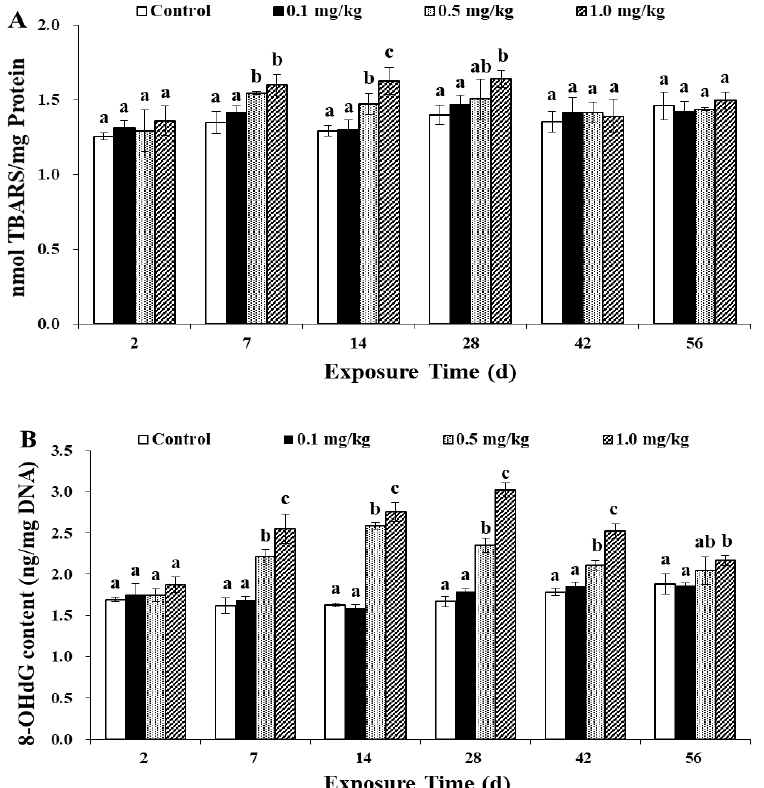
Figure 5. E ff ects of sulfoxaflor on the thiobarbituric acid reactive substances (TBARS) ( A ) and 8-OHdG ( B ) content in earthworms. Bars are the means ± SD of five replicates. Di ff erent letters indicate significant di ff erences ( p < 0.05) between treatments.